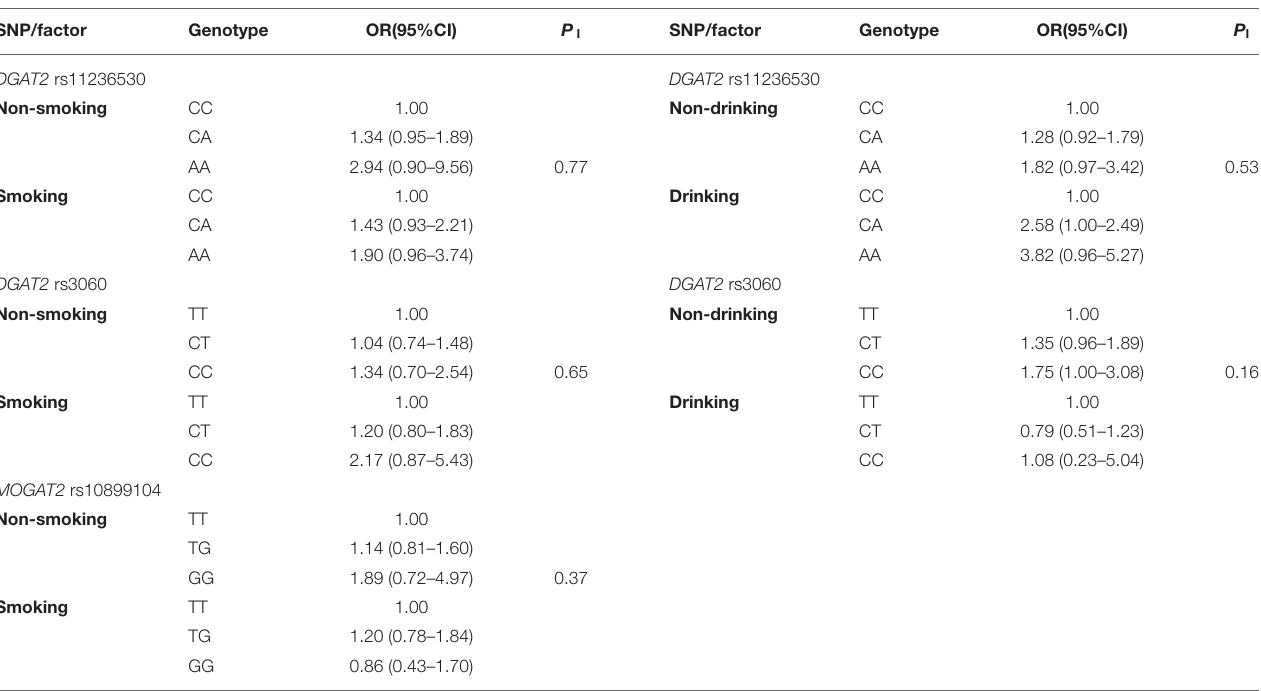
TABLE 7 | Interactions of the genotypes and smoking /drinking on the risk of IS.